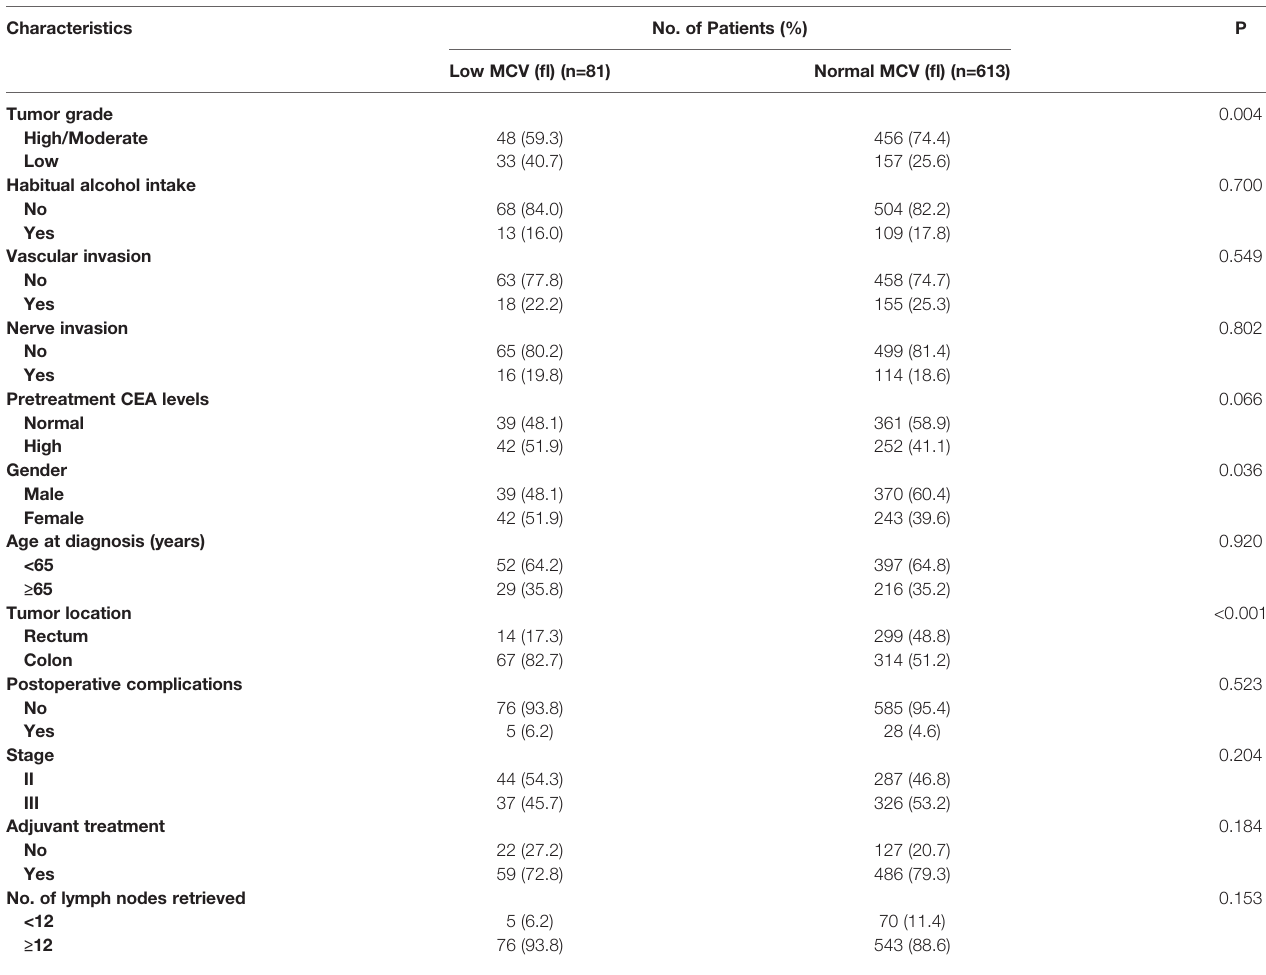
TABLE 1 | Baseline characteristics of the of the overall cohort by the levels of pretreatment MCV.